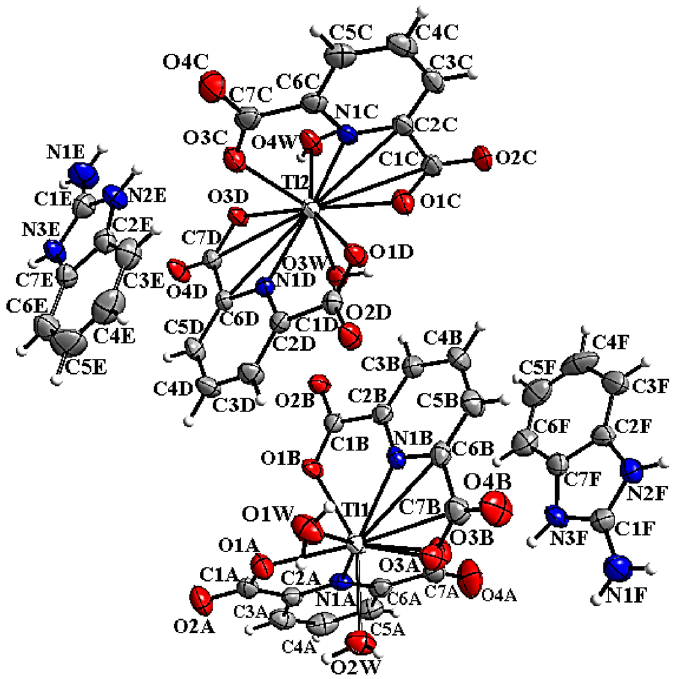
Figure 1. Molecular structure of C1 showing the atom numbering scheme with 50% probability of thermal ellipsoids.